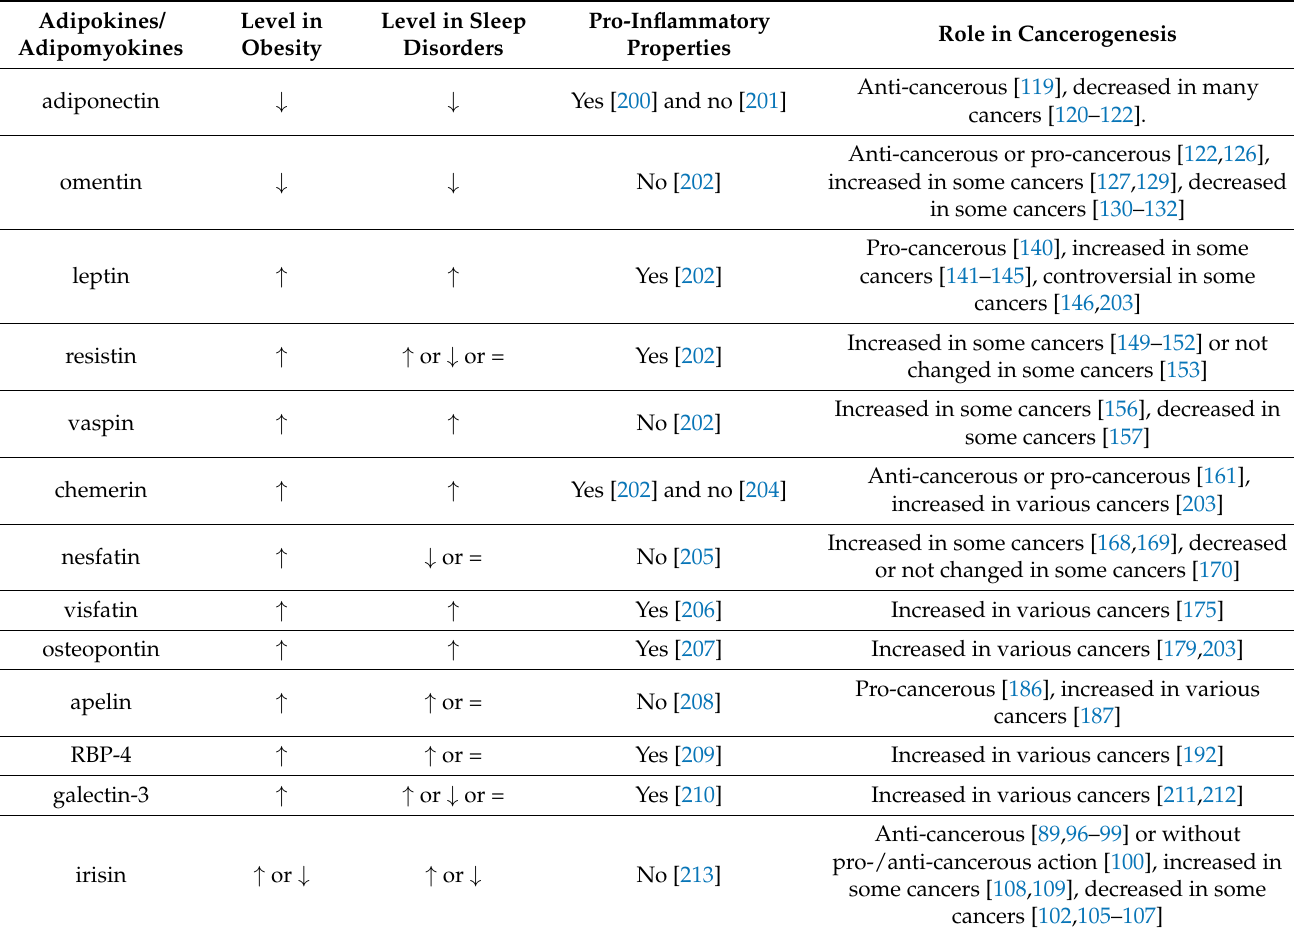
Table 1. The associations between adipokines/adipomyokines and their pro-inflammatory properties with obesity, sleep disorders and